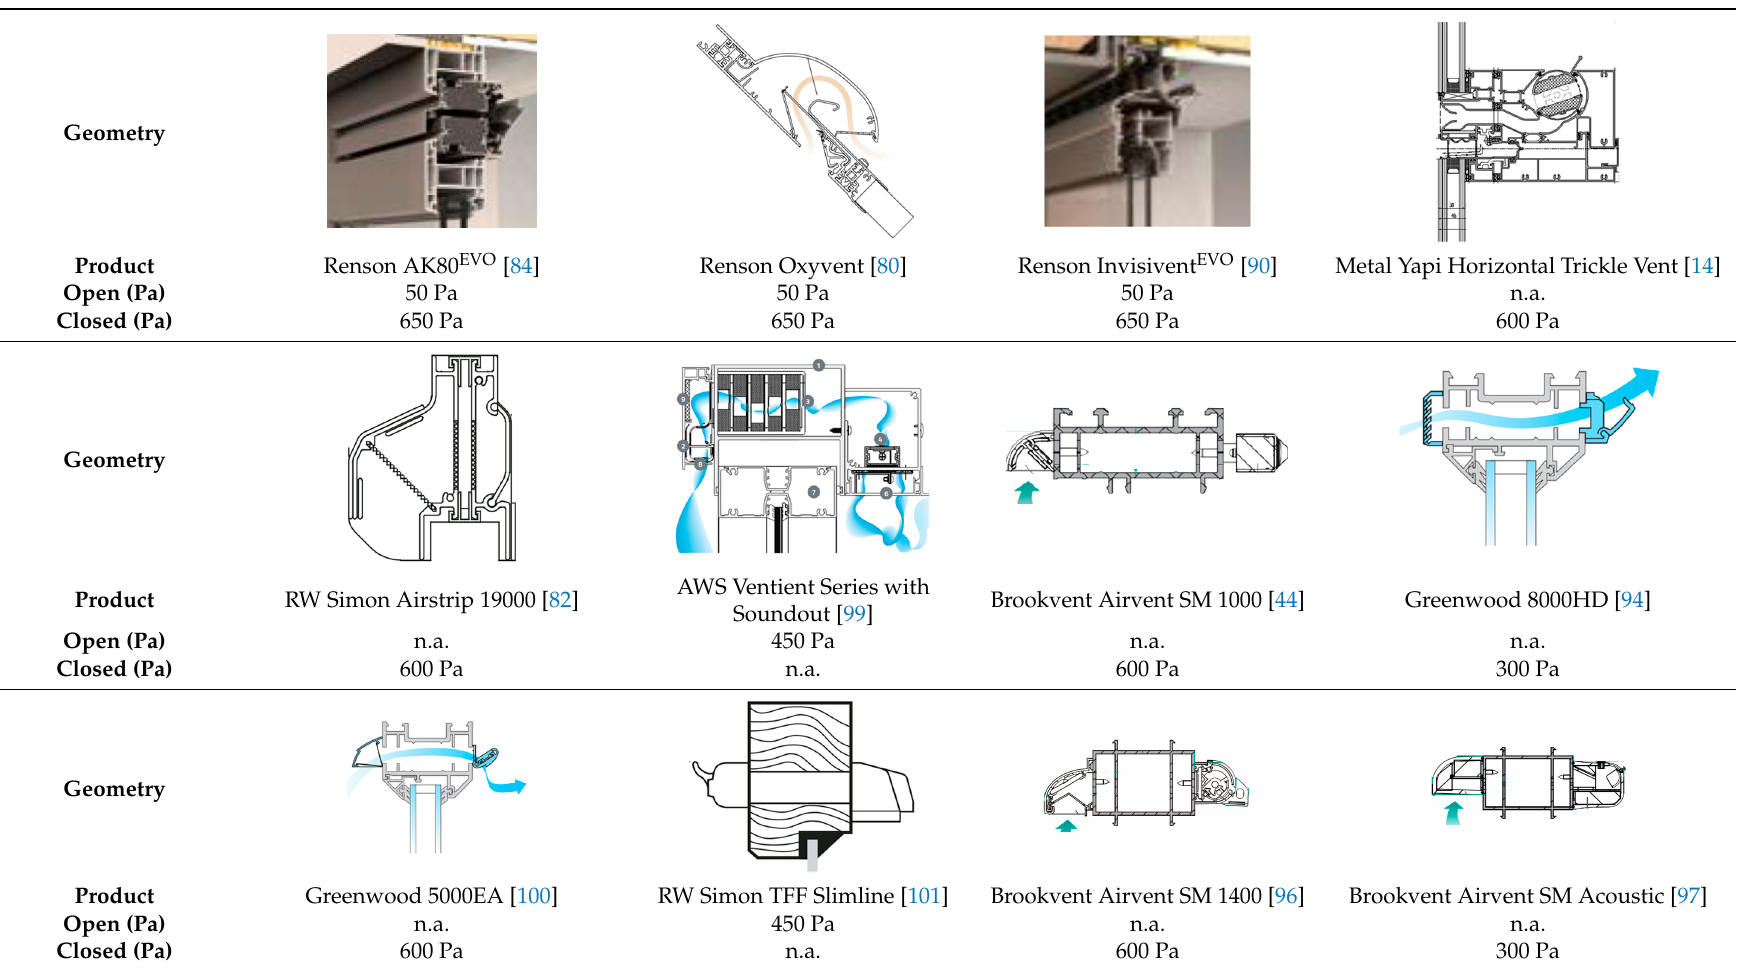
Table 13. Water tightness performance of various Trickle Vents.